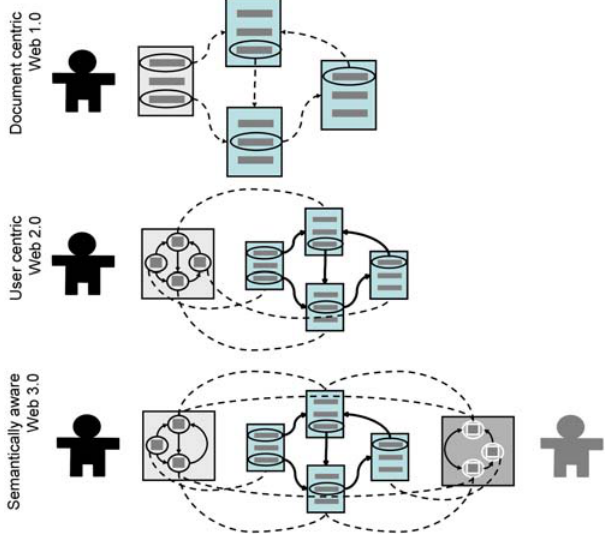
Figure 1. Three generations of design patterns for web-based applications. The original design (‘‘1.0’’) consists of collections of hypertext documents that are syntactically (dashed lines) interoperable (traversing between them by clicking on the links), regardless of the domain content. The user centric web 2.0 applications use internal representations of the external data structures. This representation is asynchronously updated from the reference resources which are now free to have a specialized interoperation between domain contents. An example of this approach is that followed by AJAX-based interfaces. Finally, the ongoing emergence of the semantic web promises to produce service oriented systems that are semantically interoperable such that the interface application reacts to domains of knowledge specifically. At this level all applications tend to be web-interoperable with peer-to-peer architectures complementing the client-server design of w1.0 and w2.0.